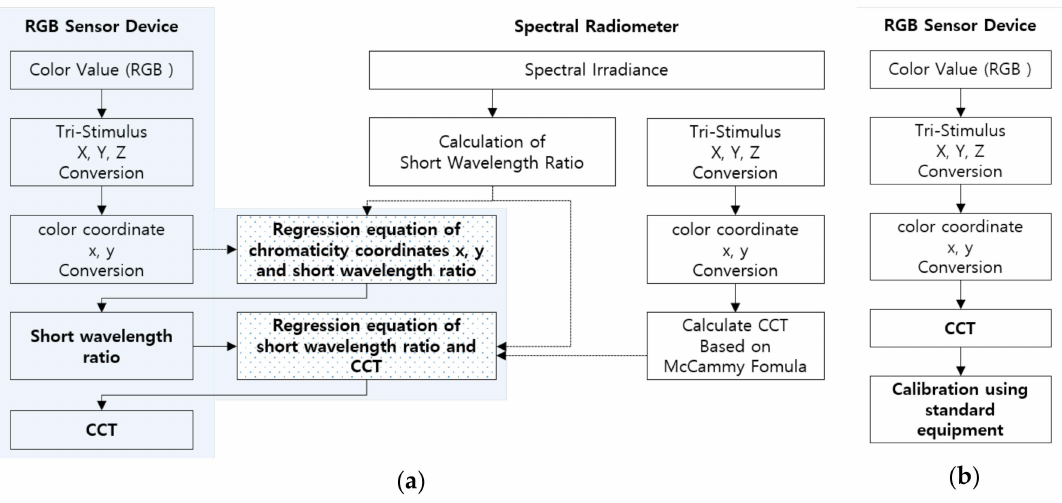
Figure4. Colortemperaturecalculationprocess: proposedmethodandexistingmethod.( a )Proposedmethod; ( b ) Existing